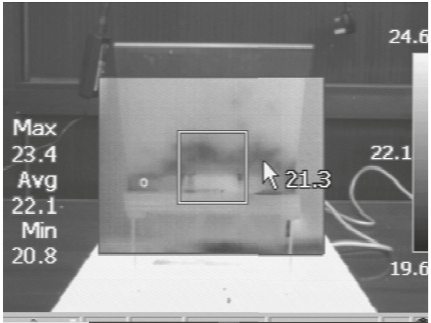
Figure 5: Thermal videos taken during drilling on the bone